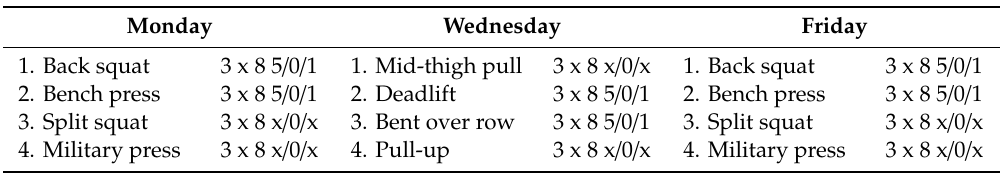
Table 1. Sample o ff -season training plan with the inclusion of tempo training to improve work capacity and cross-sectional